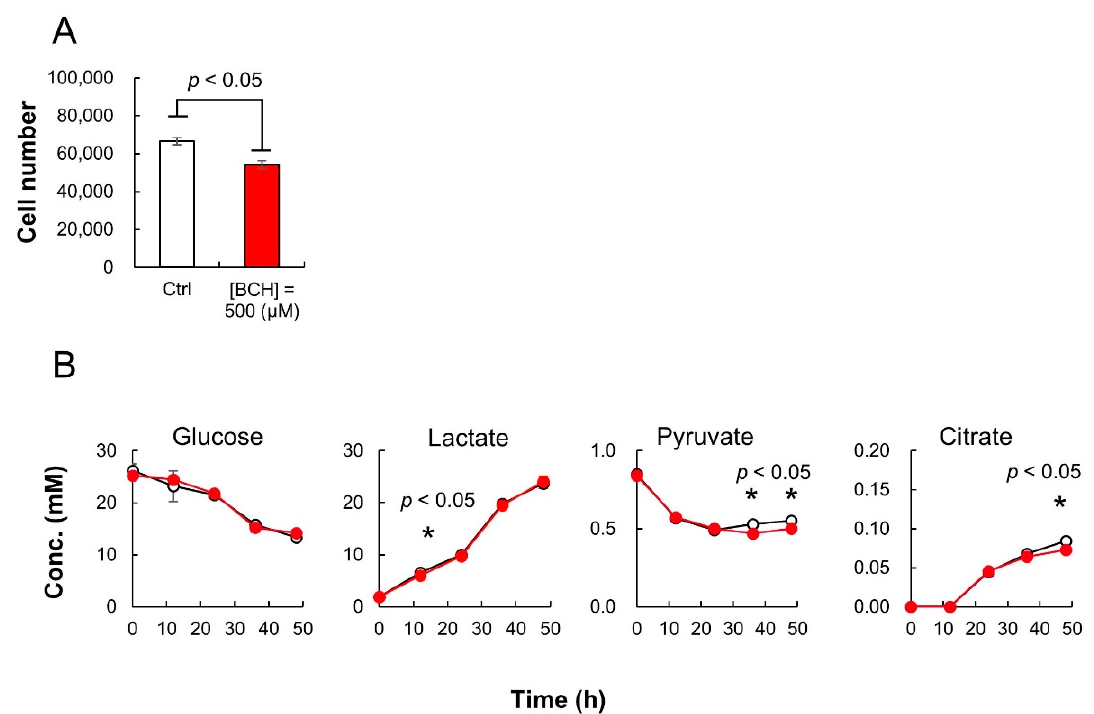
Figure 5. HeLa cell culture profiles with or without 2-aminobicyclo-(2,2,1)-heptane-2-carboxylic acid (BCH). ( A ) Cell number after 48-h cultivation with (red; (BCH) = 500 µ M) or without (white; control) BCH addition. ( B ) Time course of sugar and organic acid concentration in culture medium. White and red circles indicate the results for cultures without and with BCH addition ((BCH) = 500 µ M), respectively. Error bars indicate standard deviation ( n = 3).